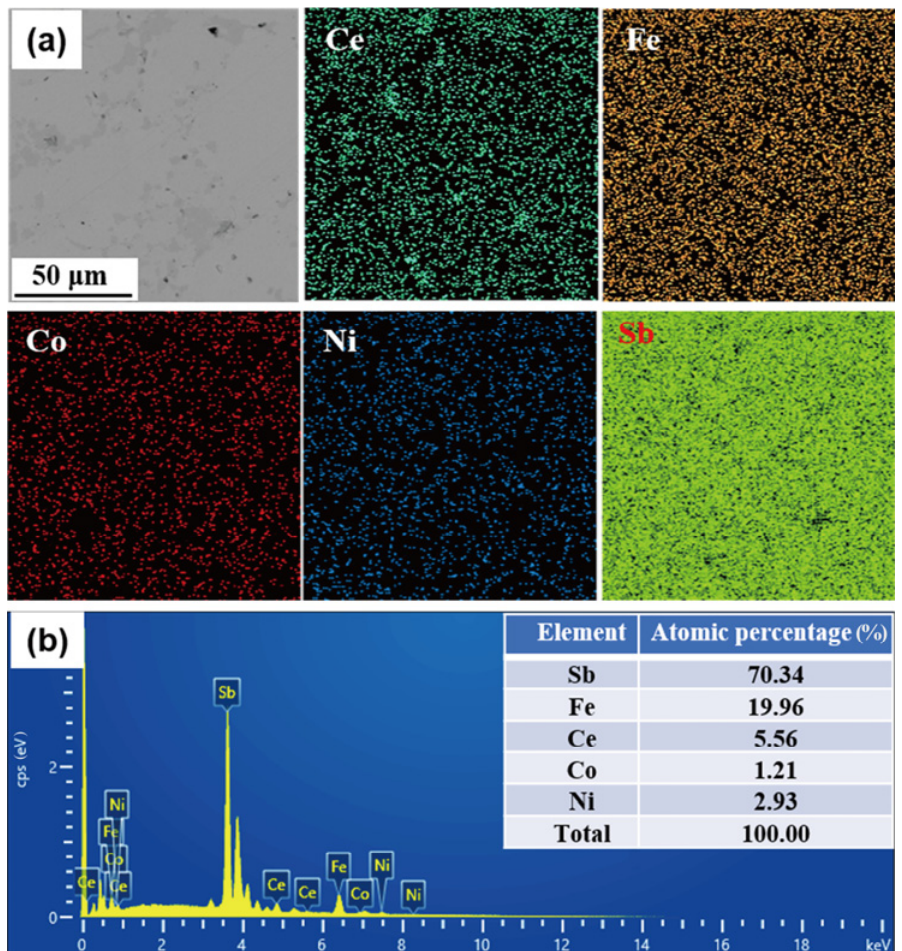
Fig. 5 (a) BEI and compositional mappings of polished surface for CeFe 3.5 Ni 0.3 Co 0.2 Sb 12 samples. (b) ED spectrum of CeFe 3.5 Ni 0.3 Co 0.2 Sb 12 samples in